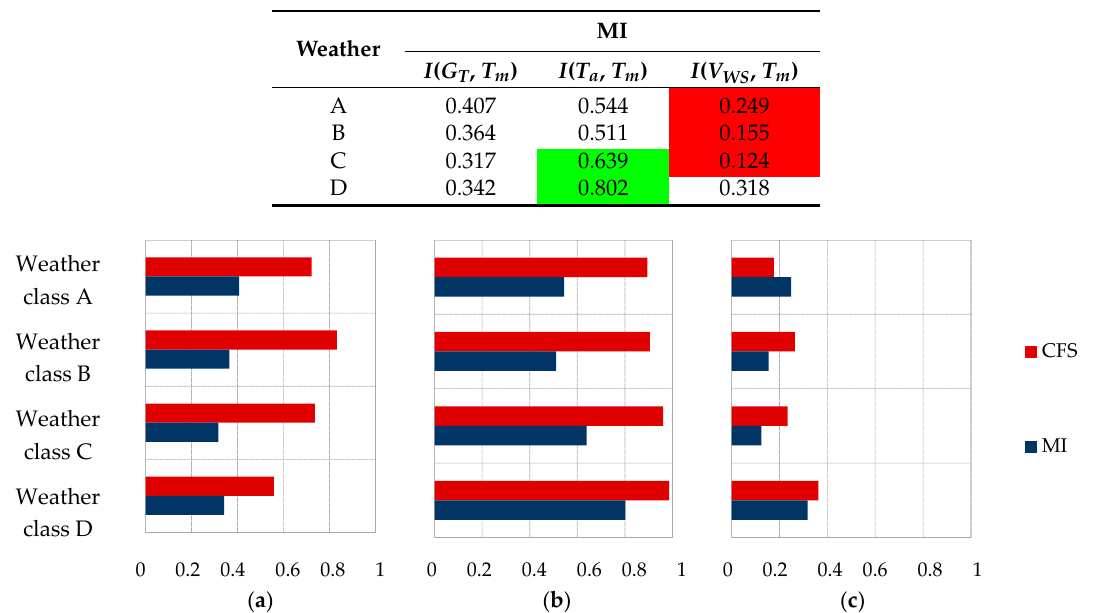
Table 9. The MI in four GWCs. The highest values are in red boxes and the lowest values are in green boxes.